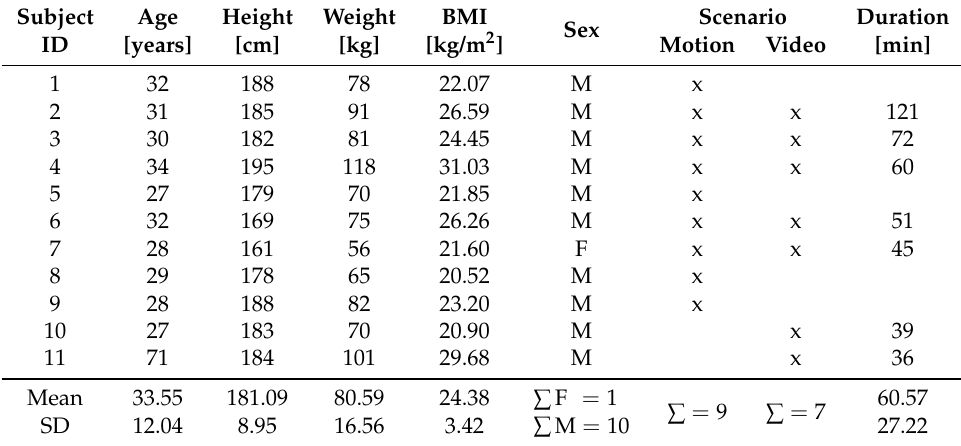
Table 1. Details on subjects who volunteered for the measurements.